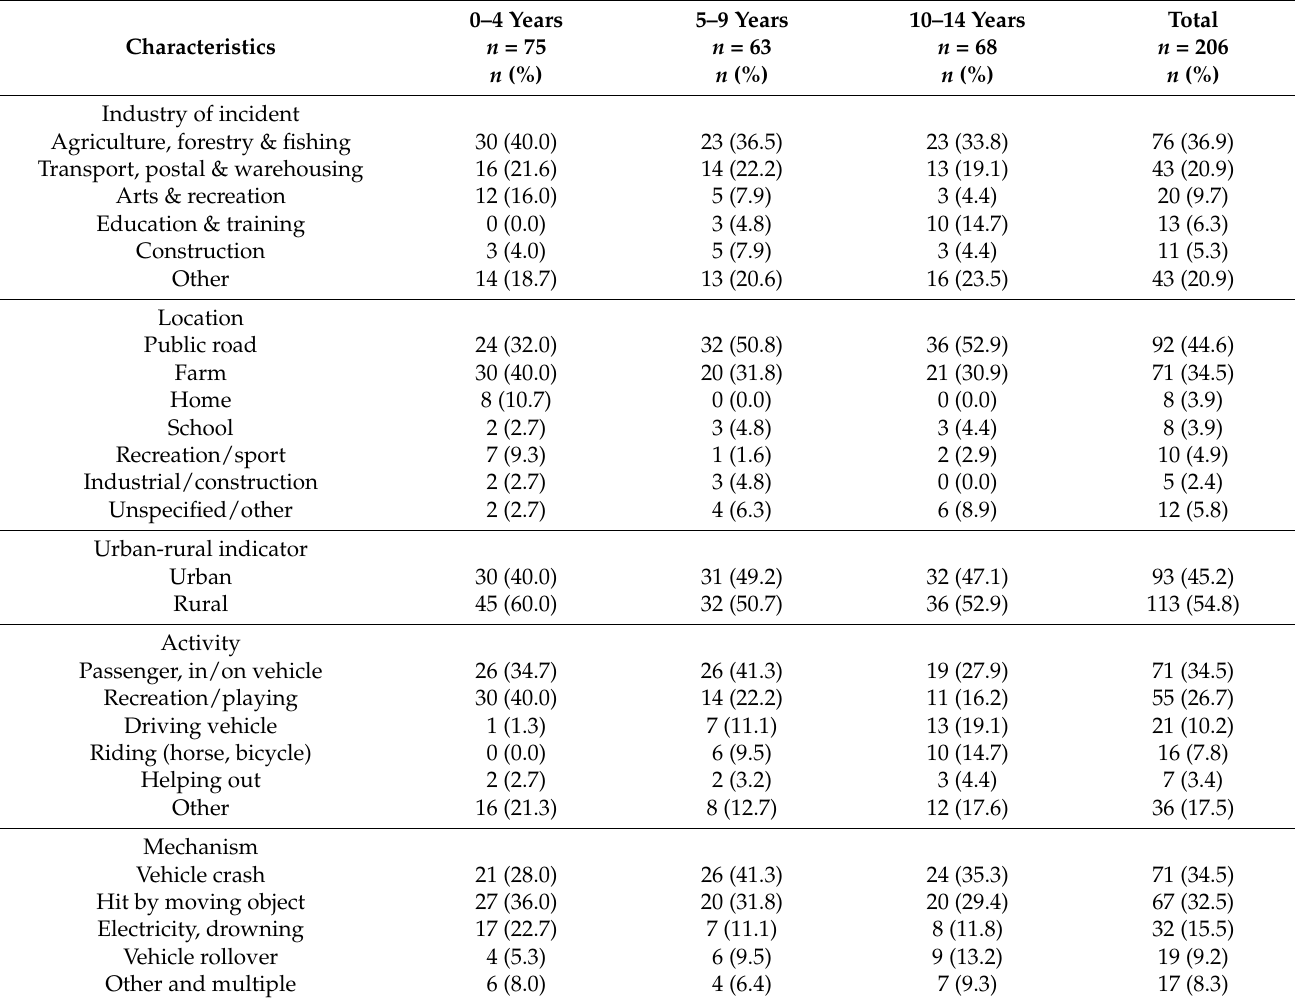
Table 3. Industry, location, activity and mechanism of work-related fatal injuries to children (0–14 years), New Zealand,